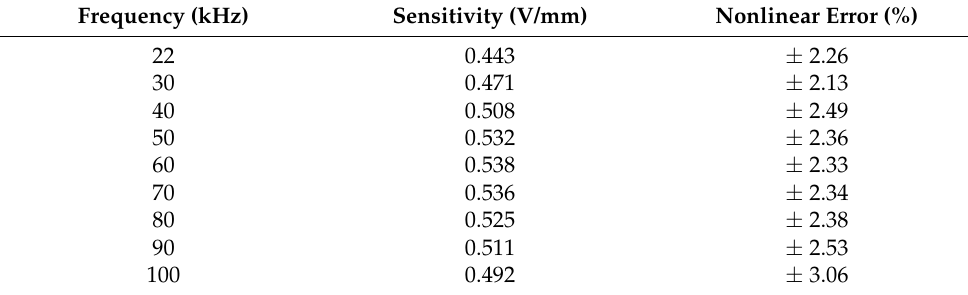
Table 2. Sensitivity and nonlinear error of the experiment.